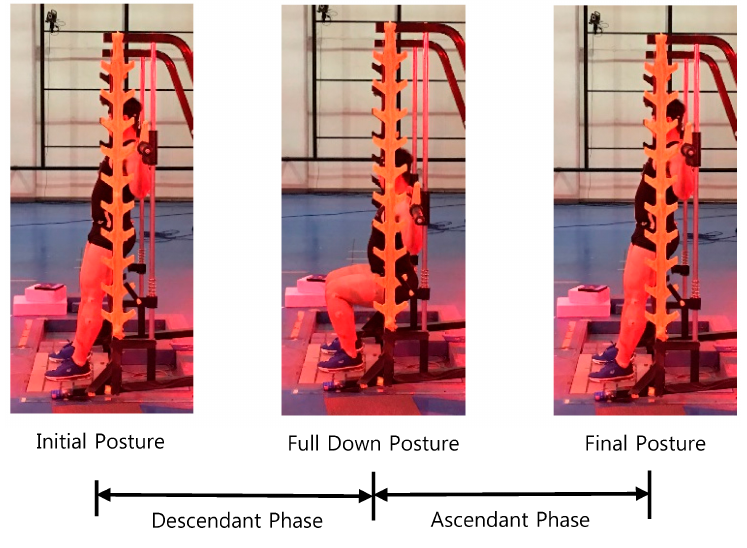
Figure 3. Squat motion cycle. Table 1. Experimental planning for Smith squats ( ○ : 10 trials, △ : 3 trials).